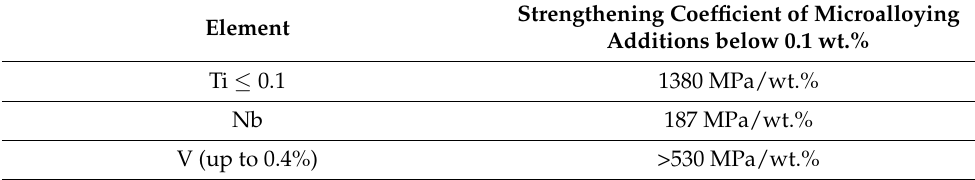
Table 2. Strengthening coefficients (MPa/wt.%) of various elements after cold rolling and annealing TWIP steels [62].